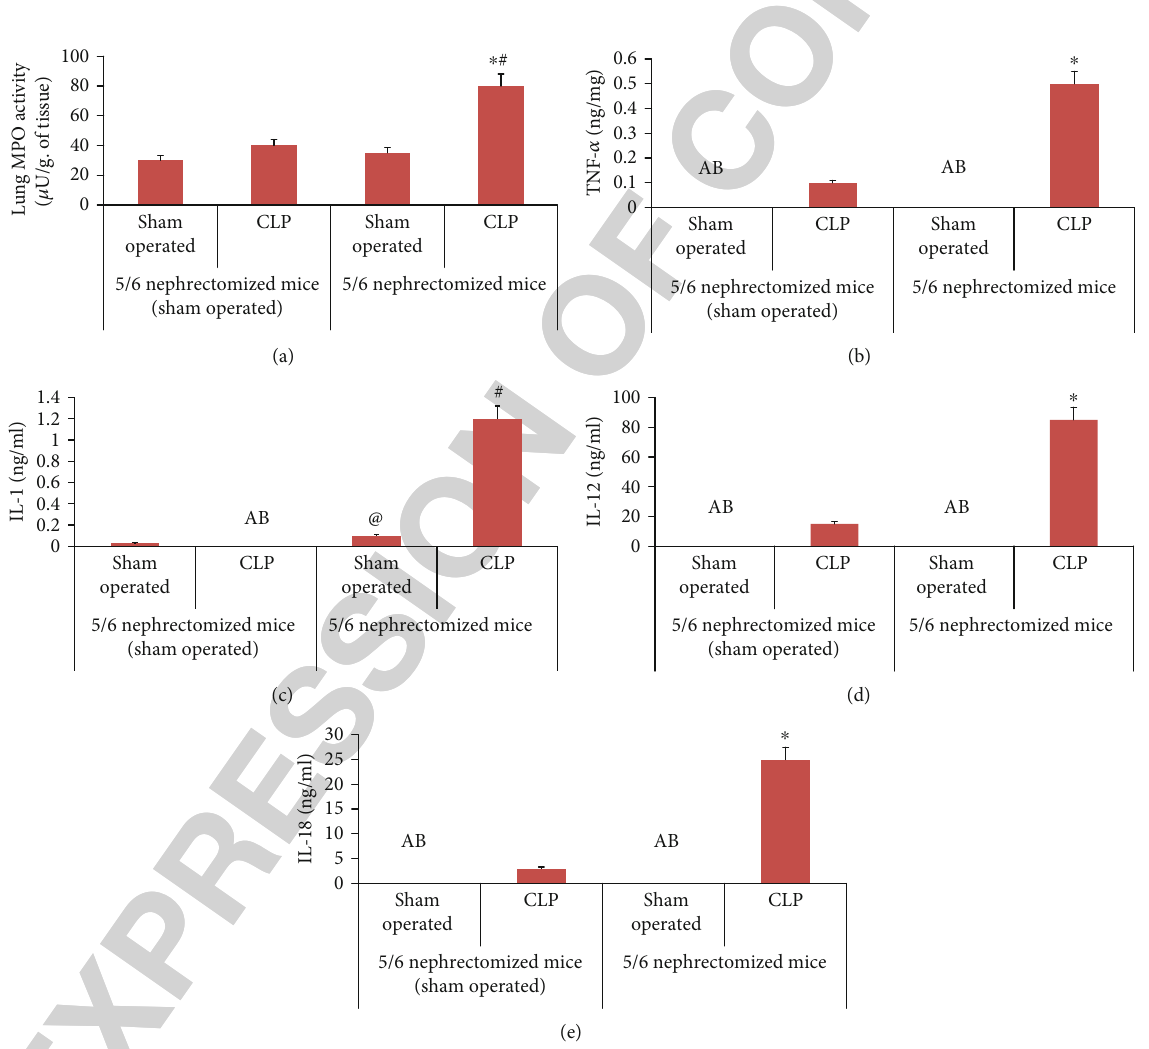
The blood creatinine, urea, and ALT levels were analyzed at 18hrs in mice treated with LPS (2mg/kg) and at 24hrs in mice subjected to CLP. The results are presented as mean ± SEM . One-way ANOVA was done followed by Bonferroni post hoc test. a P < 0 : 05 against the 5/6 nephrectomy group with mentioned treatment. b P < 0 : 05 against the respective PBS or sham group.